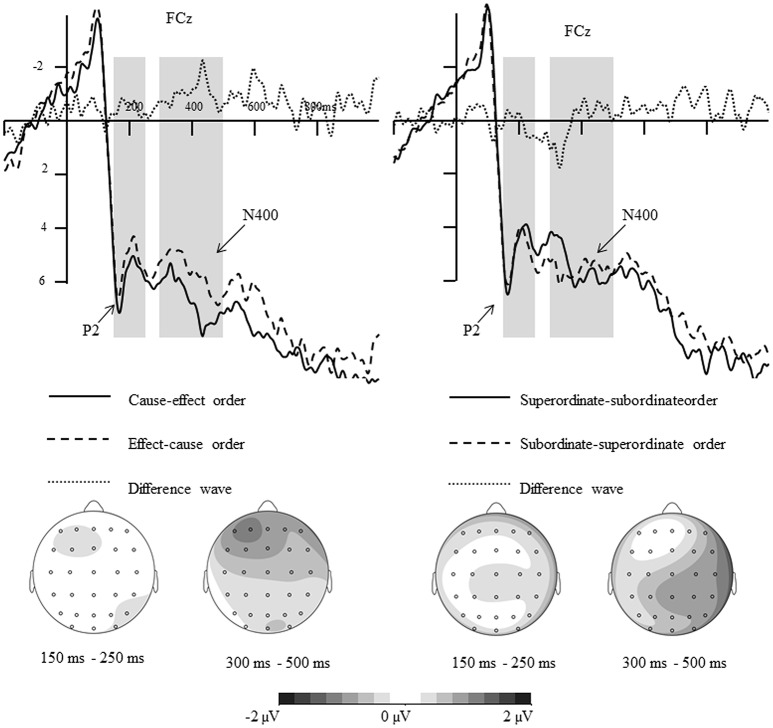
Difference waves and topographical maps among different conditions in Experiment 2 (Left: Effect-cause order subtracts cause-effect order; Right: Subordinate-superordinate level order subtracts superordinate-subordinate level order).